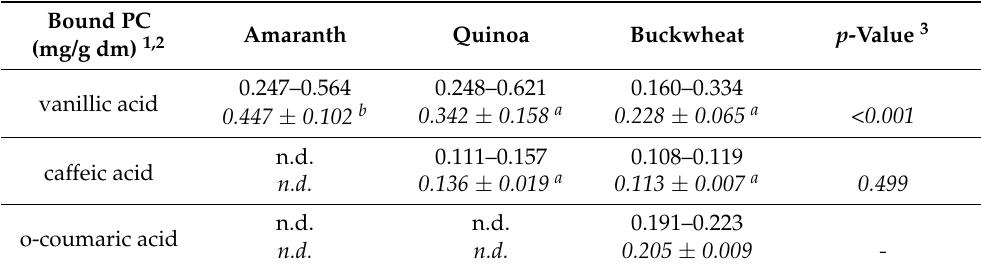
Table 8. Contents of bound phenolic compounds (mg/g dm) in amaranth ( n = 8), quinoa ( n = 7) and buckwheat ( n = 10) wholemeal flour.